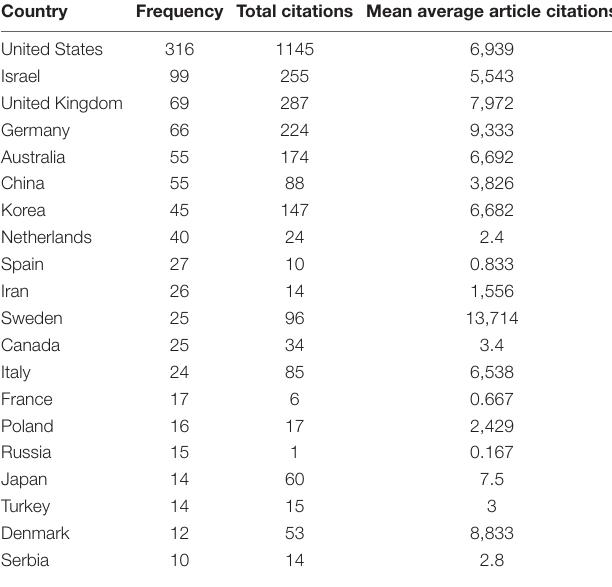
TABLE 2 | Scientific production in art therapy, by country, with a minimum frequency of 10